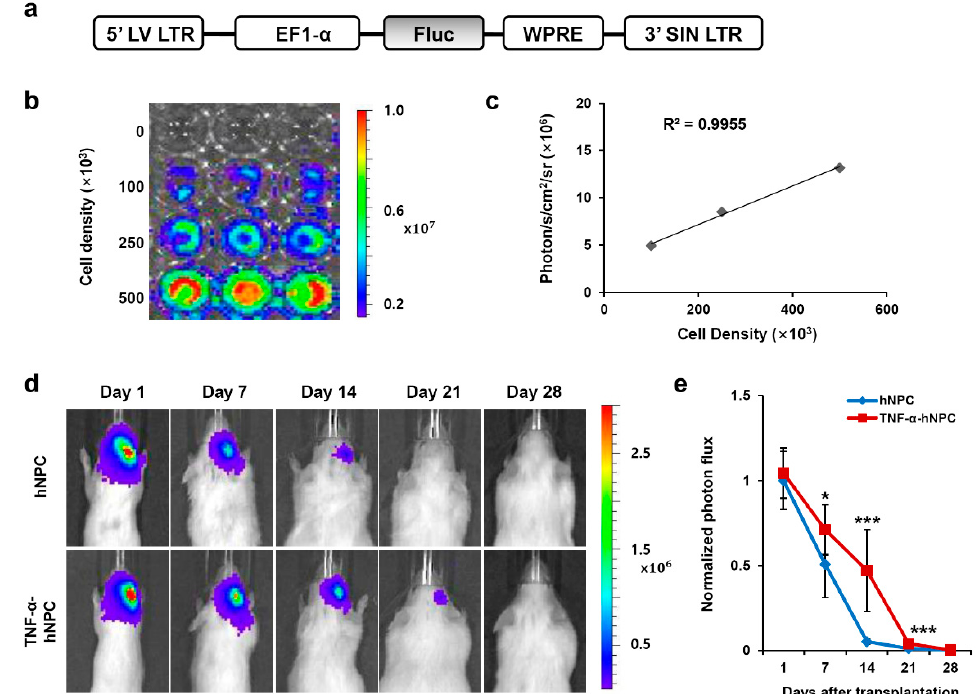
Figure 1. TNF- α pretreatment improved human neural progenitor cell (hNPC) survival in Hypoxic-Ischemic (HI)-injured mouse brain. BLI analysis of transplanted TNF- α -pretreated hNPCs and untreated hNPCs into HI-injured brain. BLI was used to track hNPC survival in vivo for 4 weeks after transplantation. ( a ) Structure of lentiviral vector carrying Fluc under the control of EF-1 α promoter. ( b ) In vitro imaging analysis of genetically engineered hNPCs shows increasing Fluc activity with cell density. ( c ) Strong correlation (R2 = 0.9955) was observed between luciferase activity and cell numbers. The data are representative of three independent experiments performed in triplicate. ( d ) Representative images of HI-injured mice transplanted with hNPCs or TNF- α -hNPCs are shown. The color scale bar is in photon / s / cm 2 / sr. ( e ) Bioluminescent signals normalized to signals at day 1 after hNPC injection (n = 13 per group). * p < 0.05 and *** p < 0.001. Data are presented as the mean ± SEM. Abbreviations: p / s / cm2 / sr, photons per second per square centimeter per steridian; LV LTR, lentivirus long-term repeat; EF1- α , EF1-alpha promoter; WPRE, the post-transcriptional regulatory element